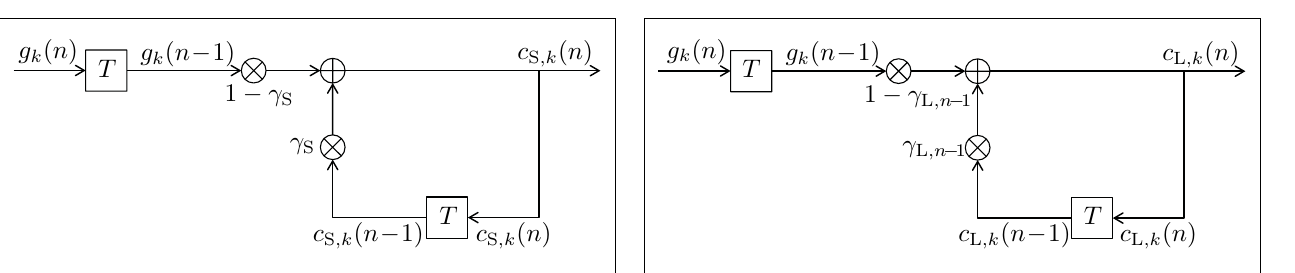
FIGURE 2 | Block diagram of a first-order infinite impulse response length (IIR) filter with transfer function H S ( f ) equivalent to (11) or (12). Elements T denote a delay of one trial. At the adder element ⊕ , updating of the weighted output γ S · c S, k ( n − 1) of the last trial n − 1 with the weighted input (1 − γ S ) · g k ( n − 1) of the last trial results in the current output c S, k ( n ). Note that via γ S · c S, k ( n − 1), all preceding inputs (and outputs) influence the current output, though for the short-term memory, the influence of trials not in the recent past is negligible.